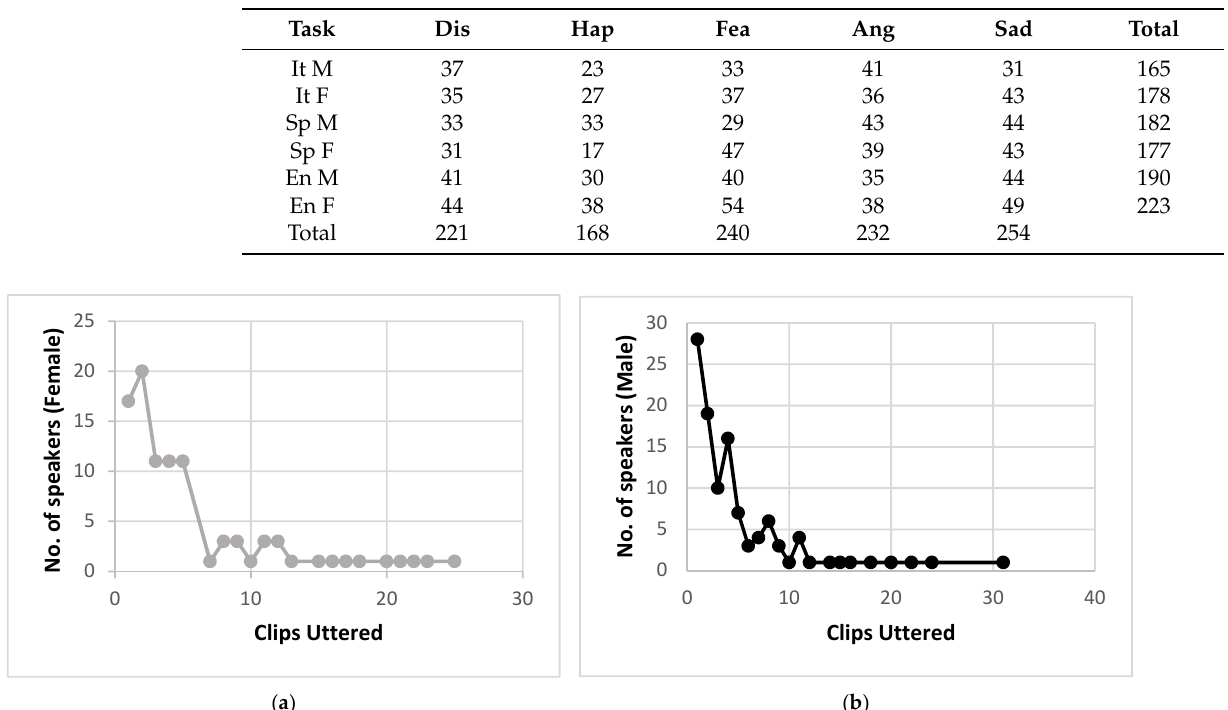
Figure 1. Number of speakers that uttered a certain number of clips ( a ) Female; ( b ) Male. As an example, 17 females uttered one clip, 20 females uttered 2 clips and, finally, one female uttered 25 clips (last point on the x -axis). Table 2. Number of clips for each emotion, each language and each gender. As an example, “It M” means “Italian Males” and there are 37 clips of Italian males labelled with the “Disgust” emotion. Last column/row shows the total of clips for all emotions/tasks.